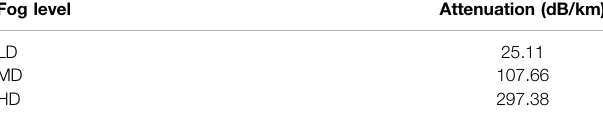
TABLE 5 | Dust level with attenuation [29].